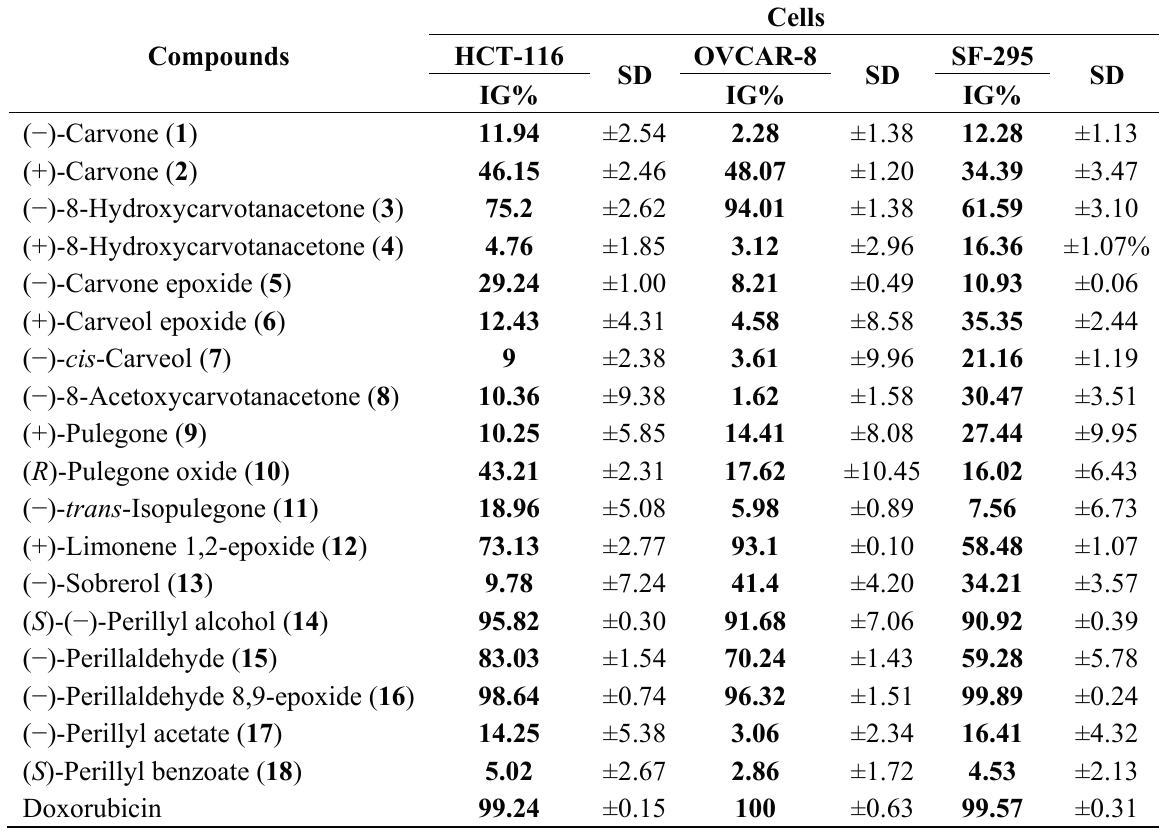
Cell lines: OVCAR-8 (ovarian adenocarcinoma), HCT-116 (colon carcinoma), and SF-295 (glioblastoma) humans. GI% values are presented as the mean ± SD of three independent experiments measured by the MTT assay after 72 h of incubation. All compounds were tested at a concentration of 25 μ g/mL. Doxorubicin was used as the positive